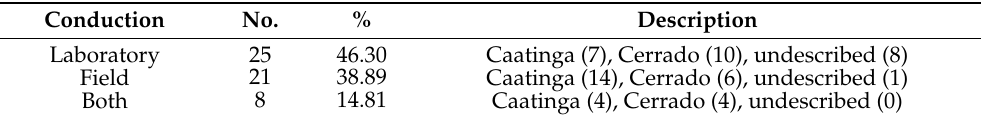
Table 1. Number and % of papers produced with information generated in field, laboratory, and both. “Description” reflects the description of the sampling site described by authors in the articles.